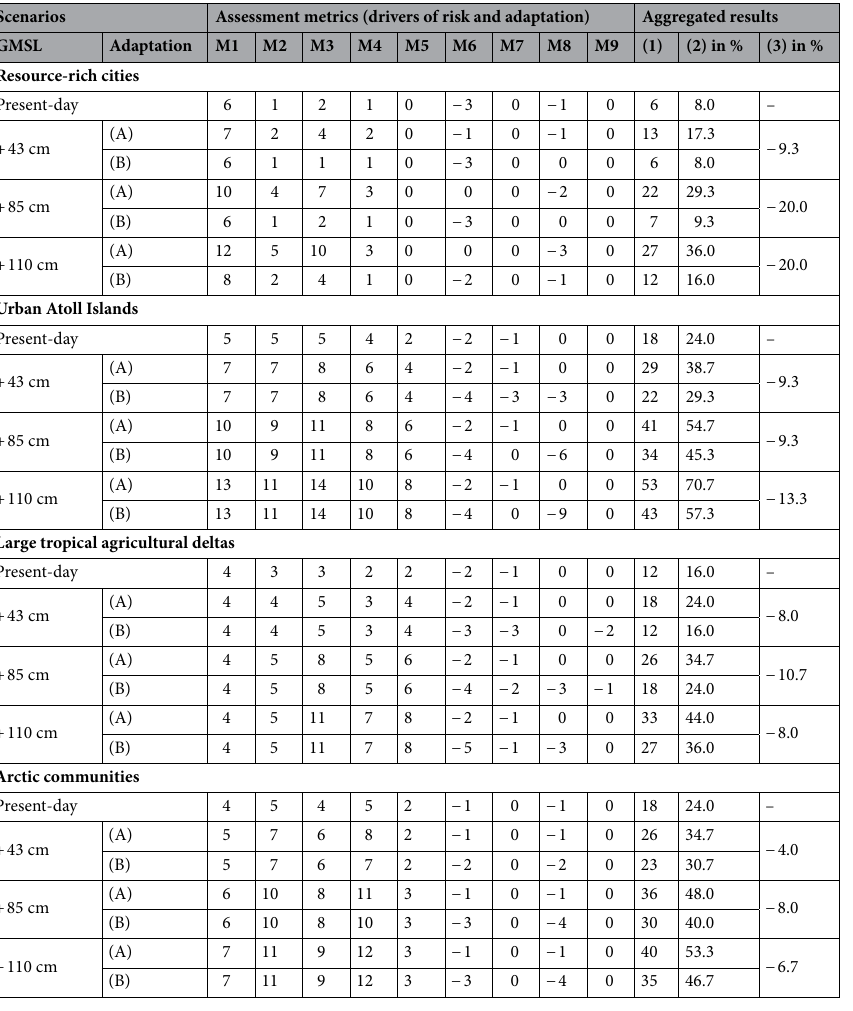
Table 2. Main results. See “Methods” section for explanations and SM2 excel file for detailed results. Columns M1-M9 and (1) represent the main results from the SROCC analysis, i.e. individual and aggregated